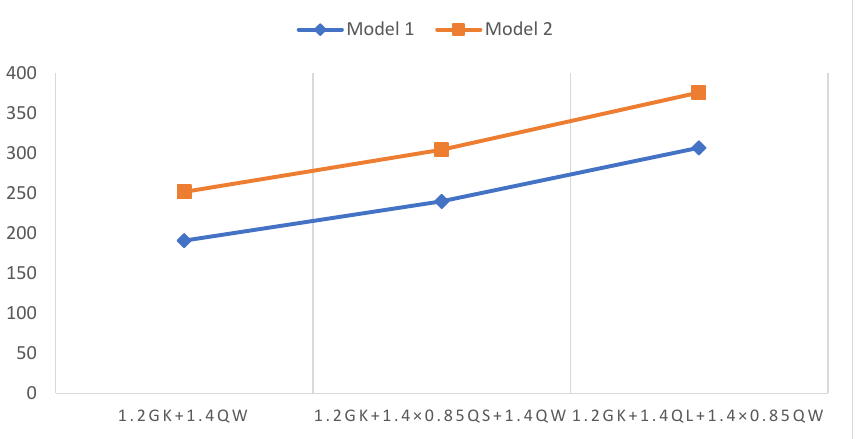
Figure 30. Nonlinear displacement broken line diagram of two carports under ultimate load. The data in the figure are obtained from the simulation results of finite element software.